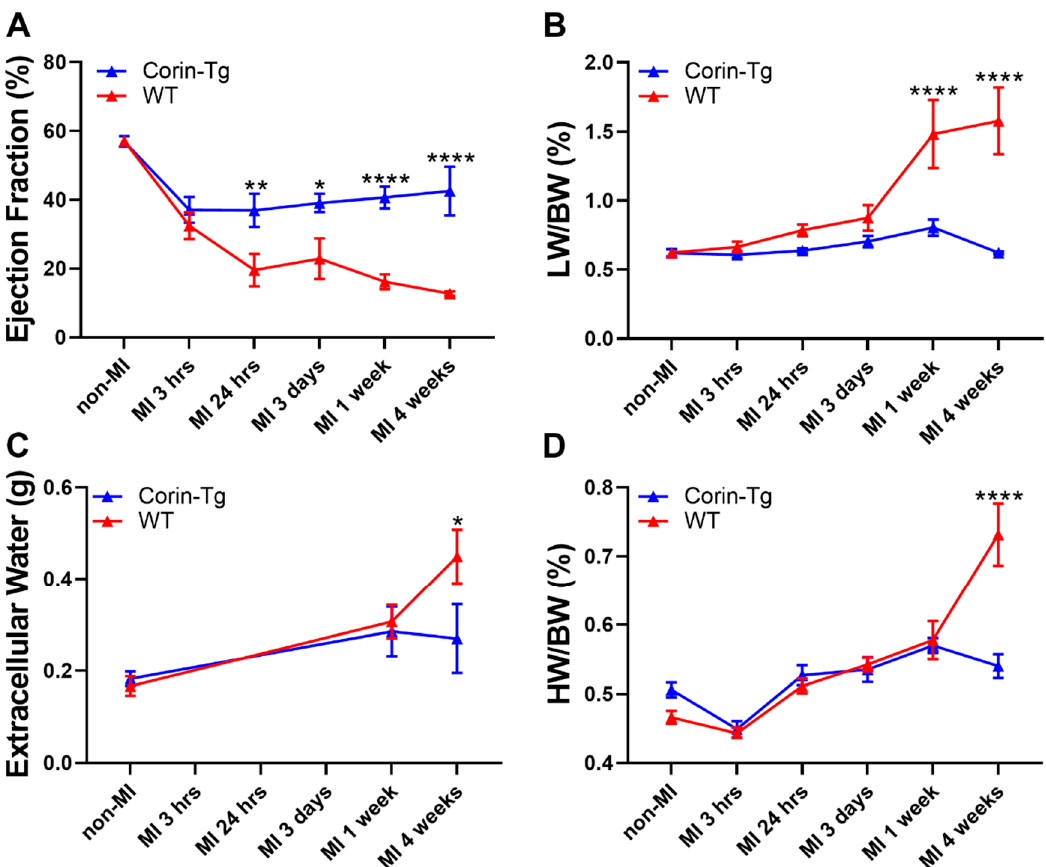
Figure 2. Cardiac-specific overexpression of corin a ff ects heart function in both early and late phase post-MI. ( A ) Dynamic changes in ejection fraction (EF%) (assessed by echocardiography), ( B ) lung weight to body weight ratio (LW/BW%), ( C ) systemic extracellular water (edema) assessed by quantitative magnetic resonance and ( D ) heart weight to body weight ratio (HW/BW%) in mouse groups of WT vs corin-Tg post-MI. Portions of data from panels A, B, and D (WT group at non-MI, 3 h, 24 h, and 3 days) have been published previously [19] and are included here to reduce animal numbers. Differences between WT and corin-Tg at each study time point were analyzed by 2-way ANOVA with Sidak’s multiple comparisons. Data represent means ± SE of n = 3–34 mice per group at each time point. * p < 0.05, ** p < 0.01, **** p < 0.0001 and not significant.